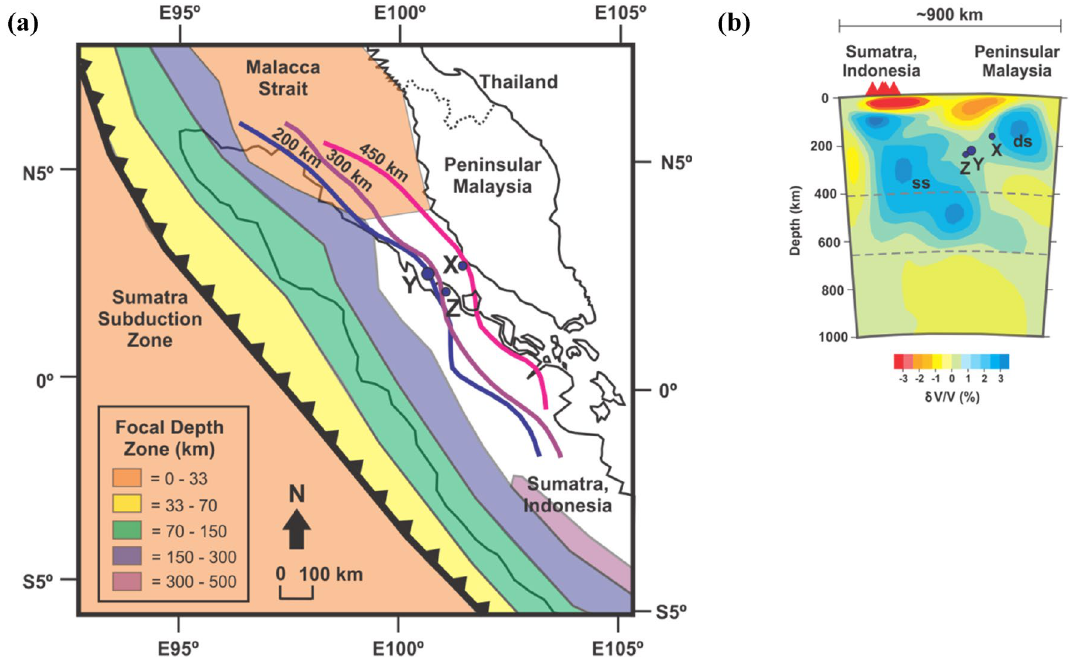
offshore Peninsular Malaysia (ML 3.1, 1992-09-25 earthquake); meanwhile, Y and Z are locations of two nearby earthquakes in the Malacca Strait of Indonesian territory, the 2004-04-29 (ML 4.8) and 1992-11-02 (ML 3.1) earthquakes, which have focal depths of 220 km and 235 km, respectively. “ss” is the subducting slab, while “ds” is the detached slab. Earthquake data occurred in the Malacca Strait both in Malaysia and Indonesian territories were obtained from ISC Online Bulletin (http:// www. isc. ac. uk/ iscbu lletin/ search/ bulle tin/). Note: Created with